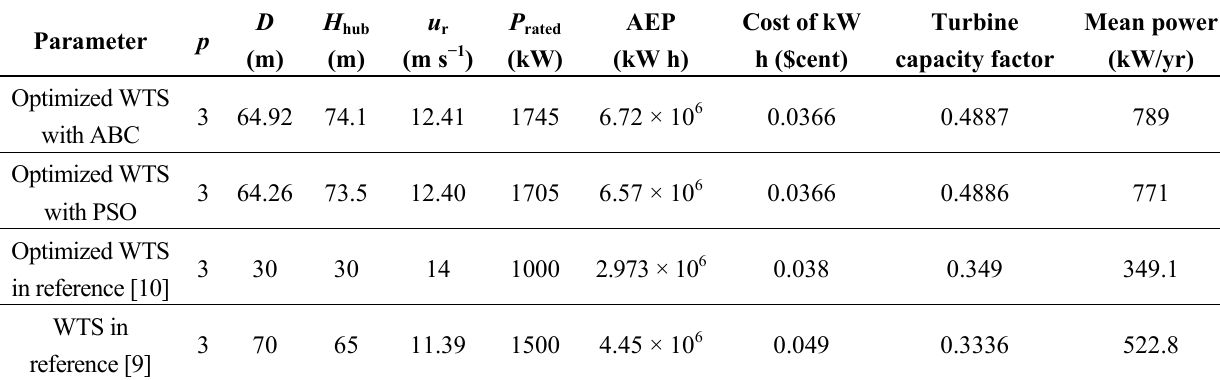
Table 4. Design parameters and performances of optimized WTS with those of reference wind turbine systems (WTSs). AEP: annual energy production; ABC: artificial bee colony; PSO: particle swarm optimization.